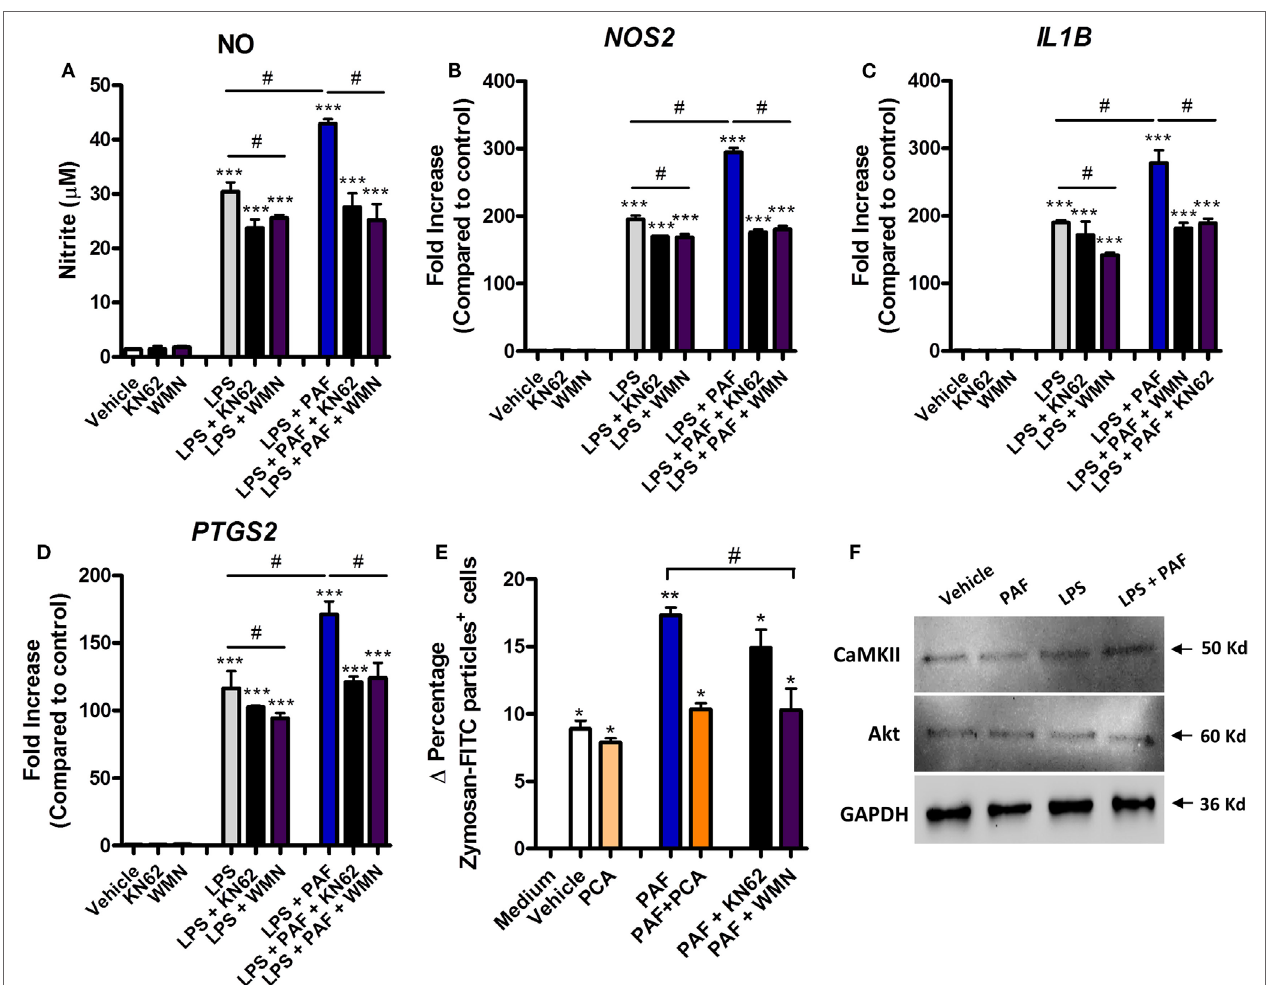
FigUre 6 | The potentiation effects of platelet-activating factor (PAF) on lipopolysaccharide (LPS)-induced pro-inflammatory response in chicken primary macrophages are partially dependent on CaM KII- and phosphatidylinositol 3-kinase (PI3K)/Akt-mediated signaling pathways. After 6 h stimulation with PAF (10 µM) and/or Escherichia coli LPS (10 ng/ml) in the presence or absence of PI3K antagonist wortmannin (WMN, 200 nM) or CaM KII antagonist (KN62, 1 µM), B13/B13 histocompatible chicken-derived bone marrow-derived macrophage (BMDM) supernatants were assessed for the presence of (a) nitric oxide, and cell lysates were used to analyze gene expression of (b) iNOS/ NOS2 , (c) IL-1 β / IL1B , and (D) COX-2/ PTGS2 by quantitative real-time PCR. Data are expressed as relative normalized expression (as compared to vehicle control group). (e) Delta percentage of BMDM containing zymosan-fluorescein isothiocyanate particles following different stimuli for 1 h as an index of phagocytosis (delta calculated after incubation at 4°C and 40°C). (F) Western blot analysis of CaM KII and Akt expression in BMDM whole cell lysates following different treatments for 6 h. GAPDH was used as loading control. Target protein size is indicated with black arrows. Values are mean ± SEM. * P < 0.05, ** P < 0.01 and *** P < 0.001 when compared to negative (vehicle or medium) control groups. # P < 0.05 when compared to positive control